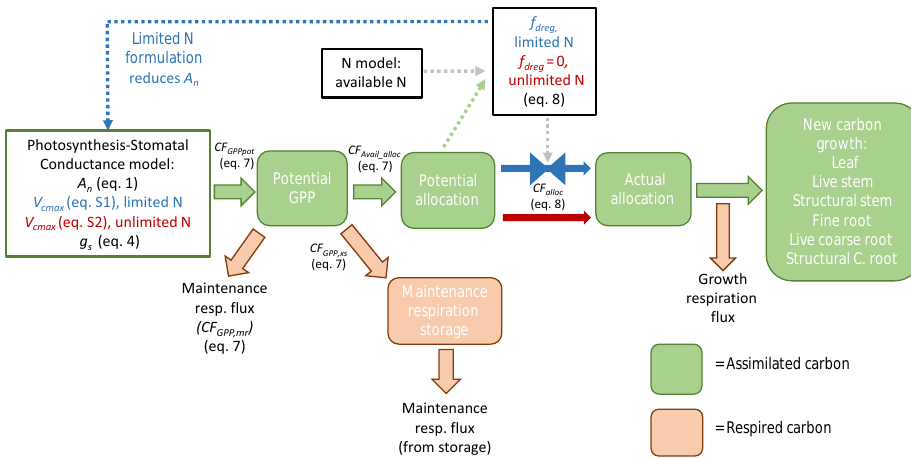
Figure 1. A simplified representation within CLM4.5 of assimilation and allocation of carbon for conifer species. The colored boxes and solid arrows represent carbon pools and carbon fluxes, respectively. The clear background boxes represent CLM submodels. N limitation is applied if the available N cannot meet the demand determined by the available carbon for allocation (CF avail_alloc ) and the C:N biomass ratio. The blue and red text and arrows represent the limited and unlimited nitrogen formulations, respectively. The no-downregulation discrimination formulation is exactly the same as the limited N formulation in this